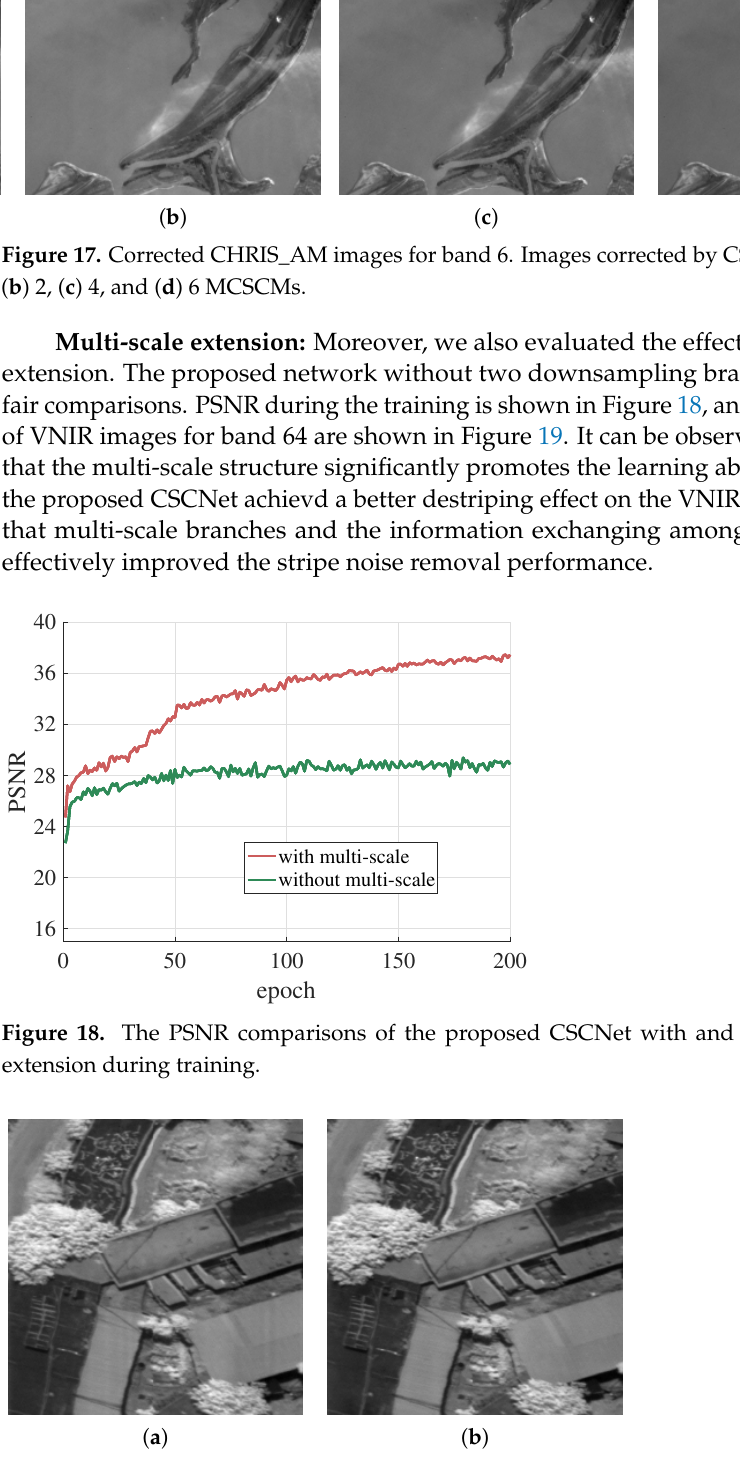
Figure 19. Corrected VNIR images for band 64. Images corrected by CSCNet ( a ) without and ( b ) with the multi-scale